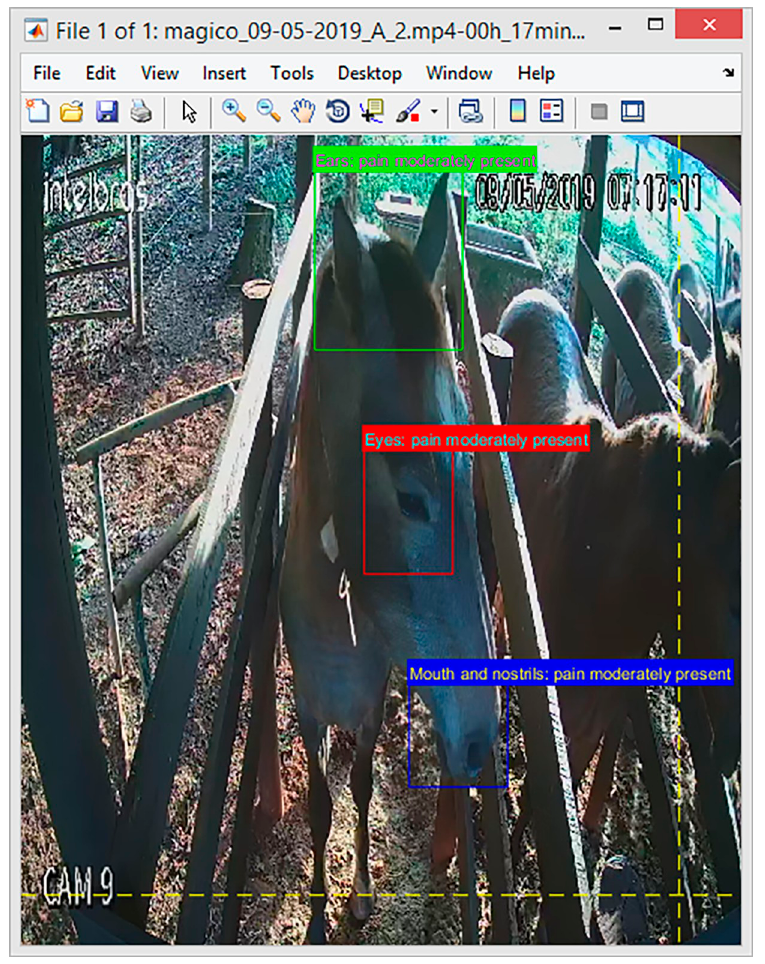
Fig 3. Window application software for the labeling process.